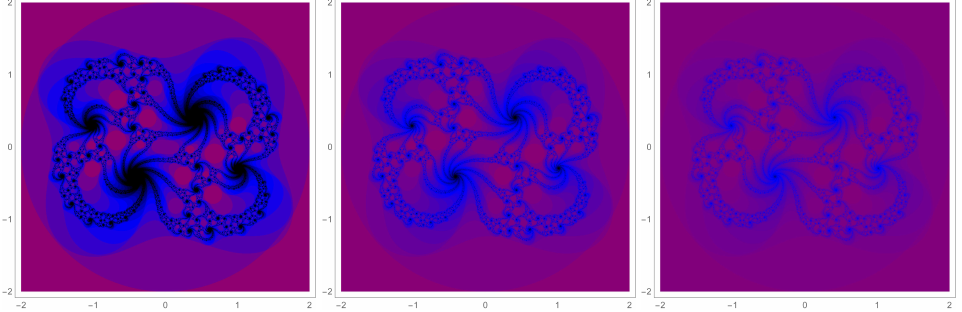
Figure 8. Effect of j on the appearance of the j -averaged filled-in Julia set associated with λ = − 0.475 + 0.13 i for (left-to-right) j = 100, j = 250, and j = 500. The set of points that are always in the filled-in Julia sets tighten up with increasing j